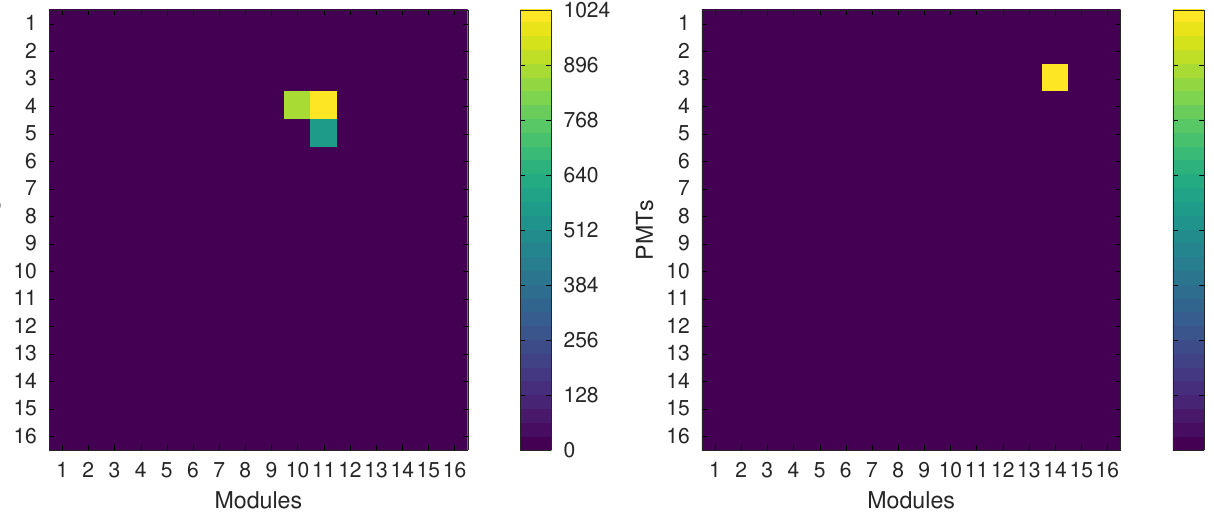
due to the way ADC codes were read out. As a result, we obtain a “dashed” track. That was a typical situation since 51 channels were dead (i.e., almost 20% of the focal surface), and PMT gains of a whole number of channels decreased drastically after the misbehavior of the HV system discussed in Section